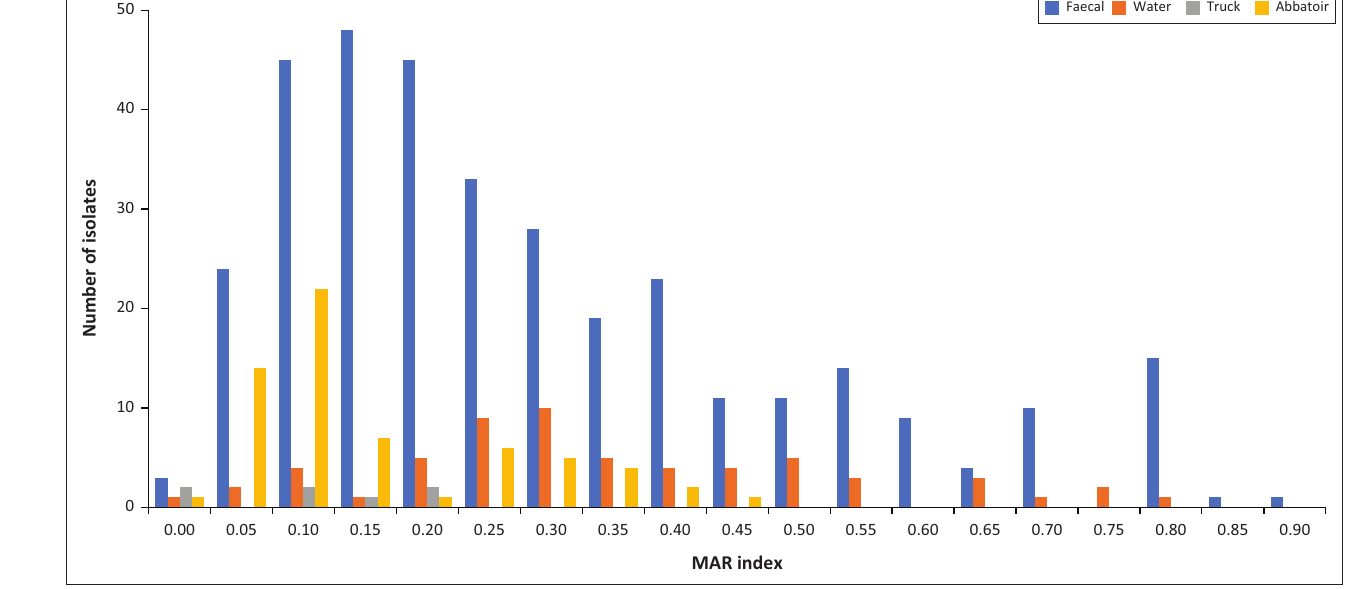
FIGURE 4: The multiple antibiotic resistance (MAR) indices of E. coli sampled across different sources (farm, water, truck and